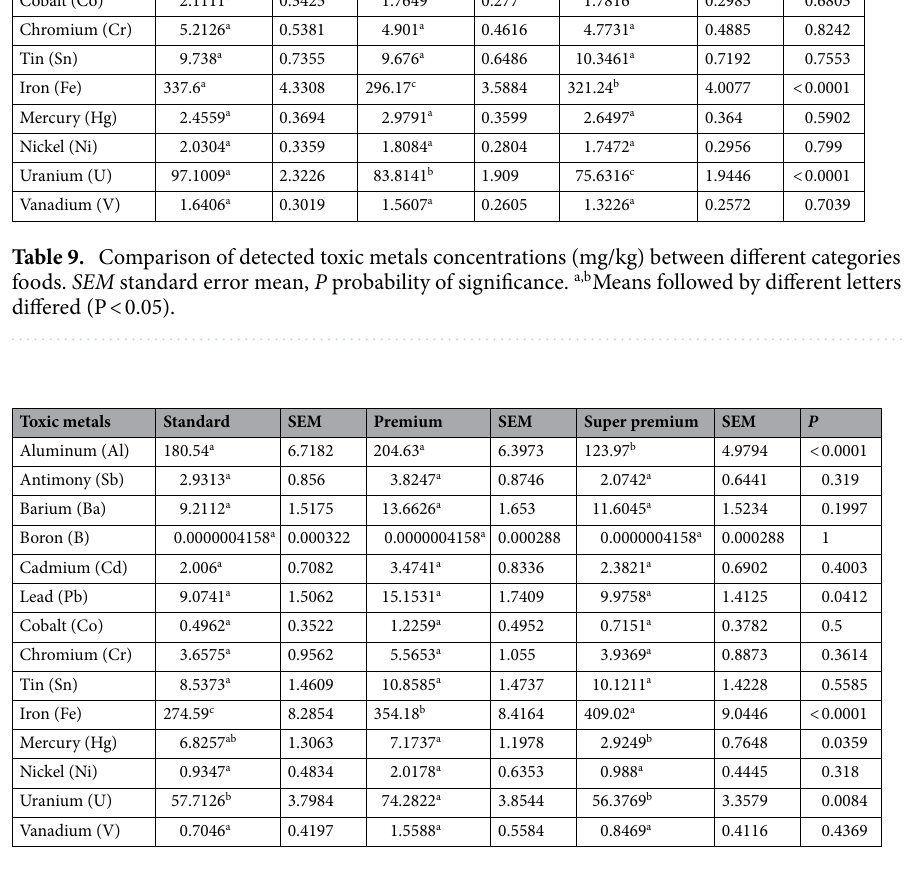
Table 10. Comparison of detected toxic metals concentrations (mg/kg) between different categories of dry cat foods. SEM standard error mean, P probability of significance. a,b Means followed by different letters in the lines differed (P < 0.05).